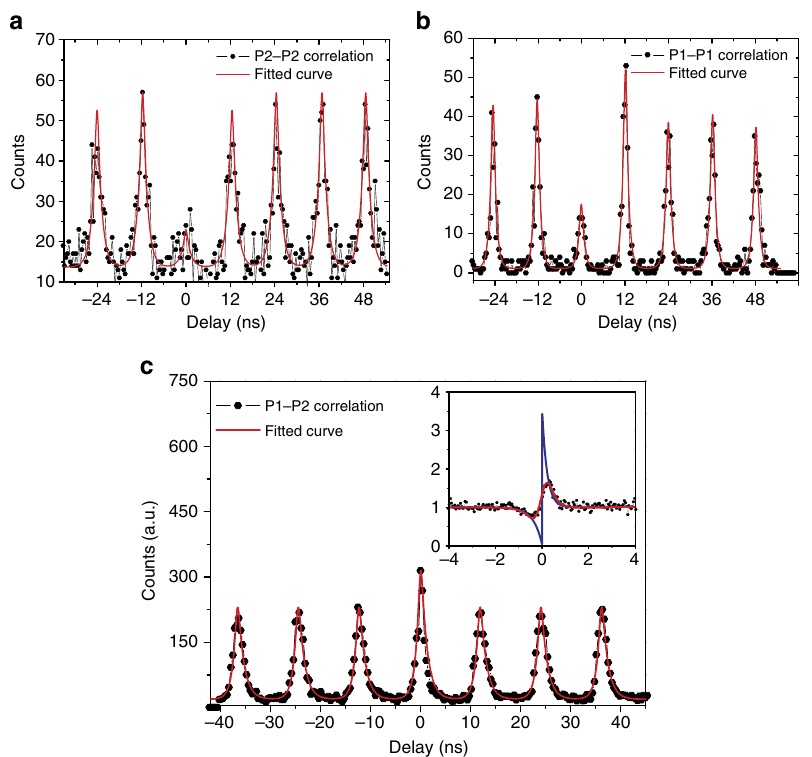
Figure 3 | Photon correlation measurements. ( a , b ) Second-order autocorrelation of measurement of the P2 and P1 under 13.6nW pulsed excitation at 475nm with the repetition rate of 82MHz and the pulse length of 3ps. We could extract g 2 (0) ¼ 0.397 ± 0.06 for P1 and g 2 (0) ¼ 0.286 ± 0.04 for P2. ( c ) Cross-correlation measurement between P1 and P2 under pulsed excitation. The obtained g 2 (0) ¼ 1.404 ± 0.038, which obviously shows the bunching effect of the emission. The red lines are fitted with two exponential decay convolved with the response function. The inset is the cross-correlation measurement of P1 and P2 under a 70nw CW laser excitation at 532nm. The red line in the inset is a fit with multiexcitonic model convolved with the response function. The blue line is the deconvoluted curve, which shows g 2 (0) ¼ 0.038 ± 0.004 for negative delay and g 2 (0) ¼ 3.434 ± 0.129 for positive delay. All uncertainties correspond to 1 s.d. For more details about fitting, see